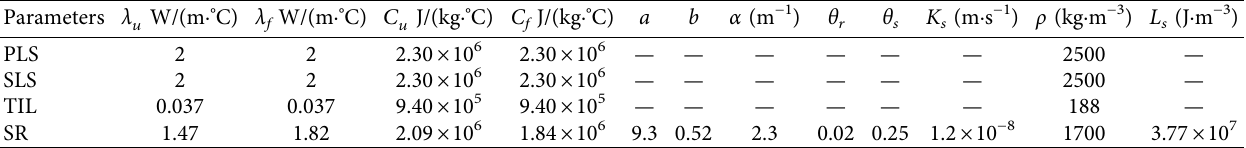
Table 1: Thermal and hydraulic parameters of lining structures, insulation layer, and SR in the